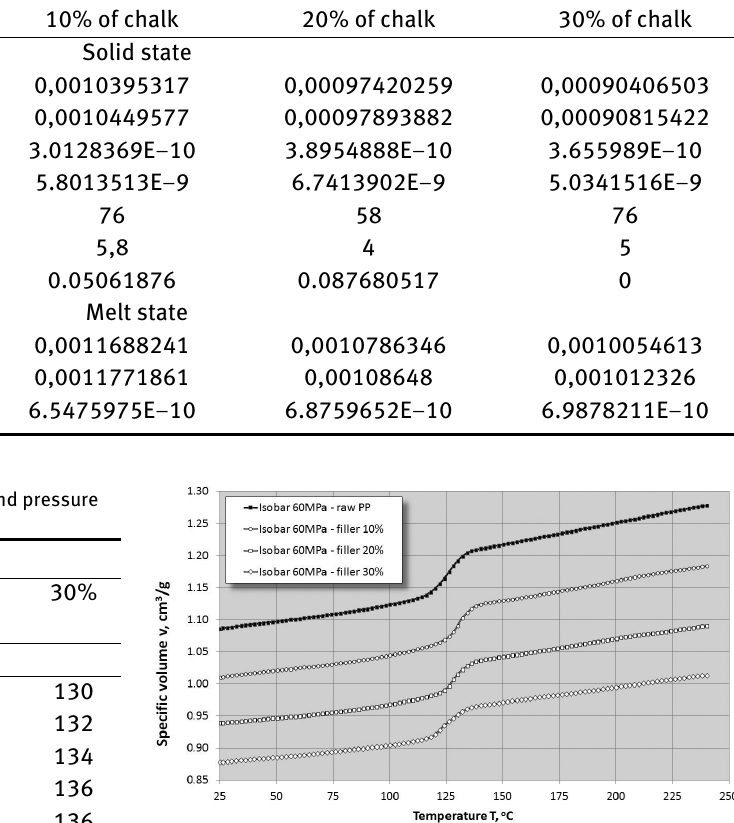
Figure 2: Example of P-v-T characteristic for raw PP Moplen RP2380 and with 10%, 20%, 30% of filler content obtained at a medium pressure 60MPa